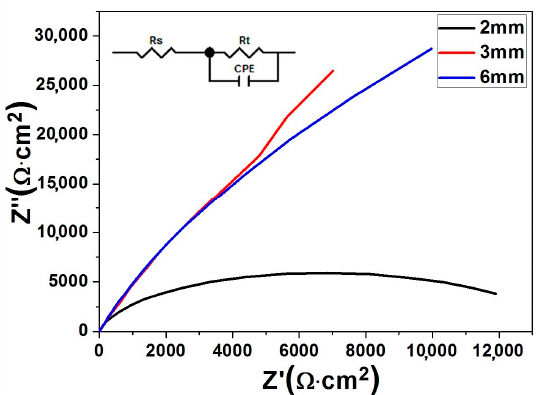
Figure 3. Nyquist plots of Ti 46 Zr 20 V 12 Cu 5 Be 17 composites with diameters of Φ 2, Φ 3, and Φ 6 mm in the 10% H 2 SO 4 solution at room temperature. The inset illustrating the corresponding equivalent circuit.